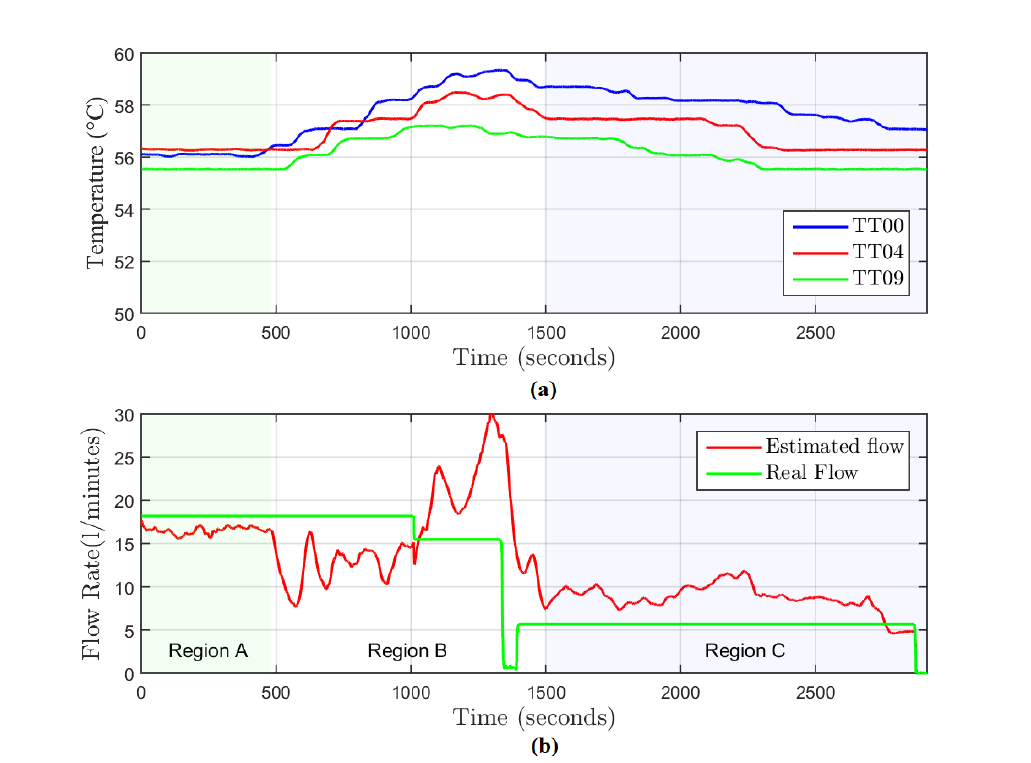
Figure 14. Graphs of temperature and flow with time. ( a ) Graph of temperature in transport zone 1. ( b ) Comparison between the real and the estimated instantaneous flow